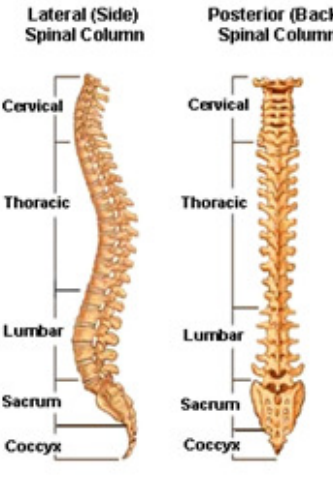
Figure 5. Spine. Source: Hospital Universitario Arnaldo Milián Castro,